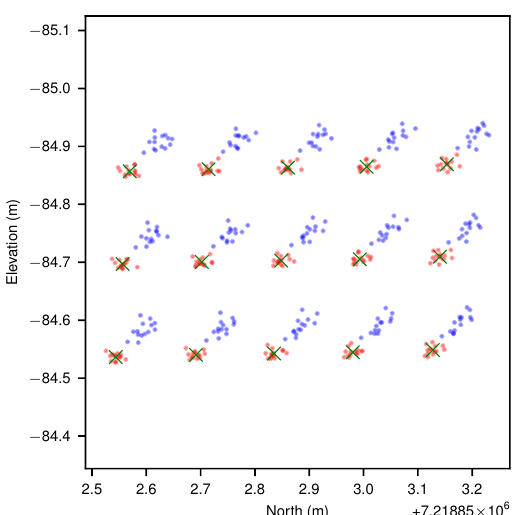
Figure 14. All pattern points plotted to best fit planes for Shrimp, red for post calibration (same as in Figure 13c) and blue for projected points resulting from a relative camera pose where the optimised orientation was altered by 1 ◦ . This demonstrates the significant effect small changes in the camera pose can have on mapping